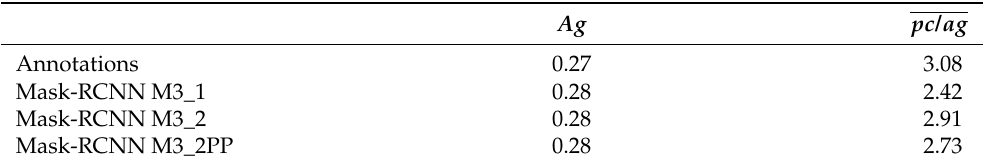
Table 2. Agglomeration degree ( Ag ) and number of primary crystals per agglomerate ( pc / ag ) for the test set; manual annotations compared to the results of different Mask-RCNN